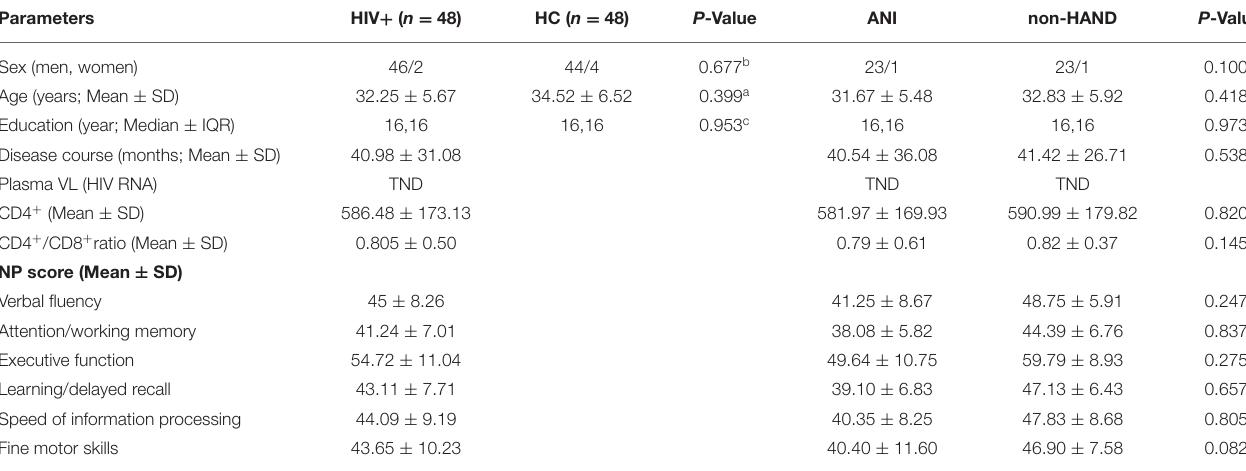
TABLE 1 | Demographic and clinical characteristics of the participants. Parameters P